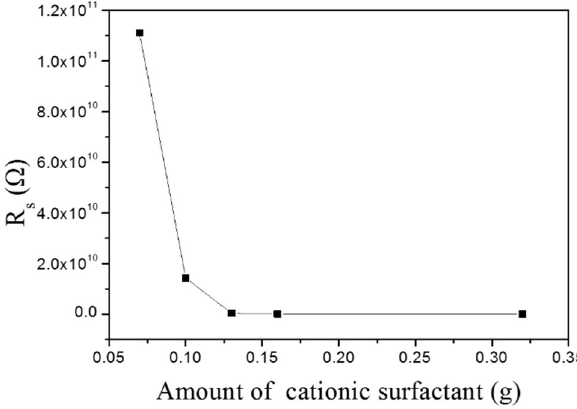
Figure 9. R (cid:3046) of MMO with different additional amounts of SN (65% RH, 500 V). Figure 9. R s of MMO with different additional amounts of SN (65% RH, 500